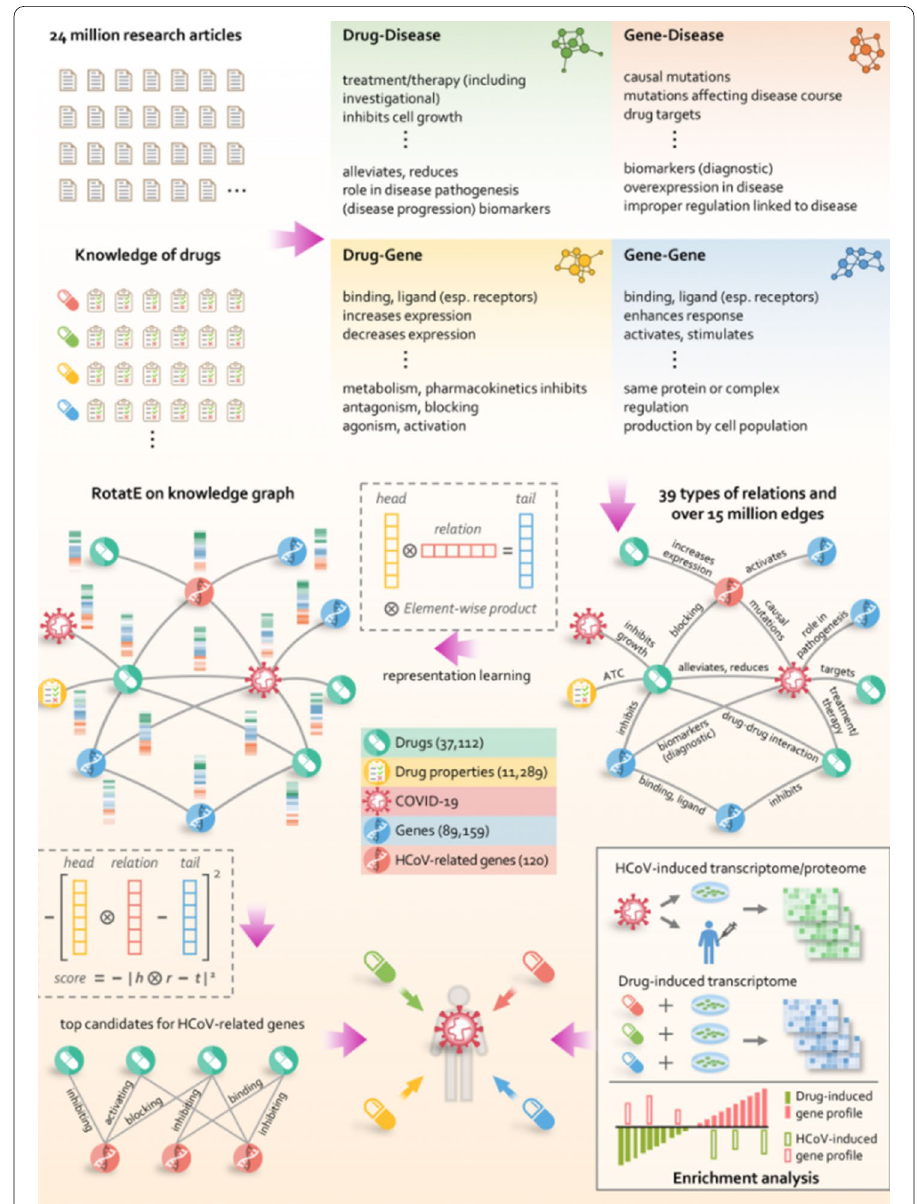
Fig. 16 Illustration of the use and construction of CoV-KGE for drug repurposing (Image taken from